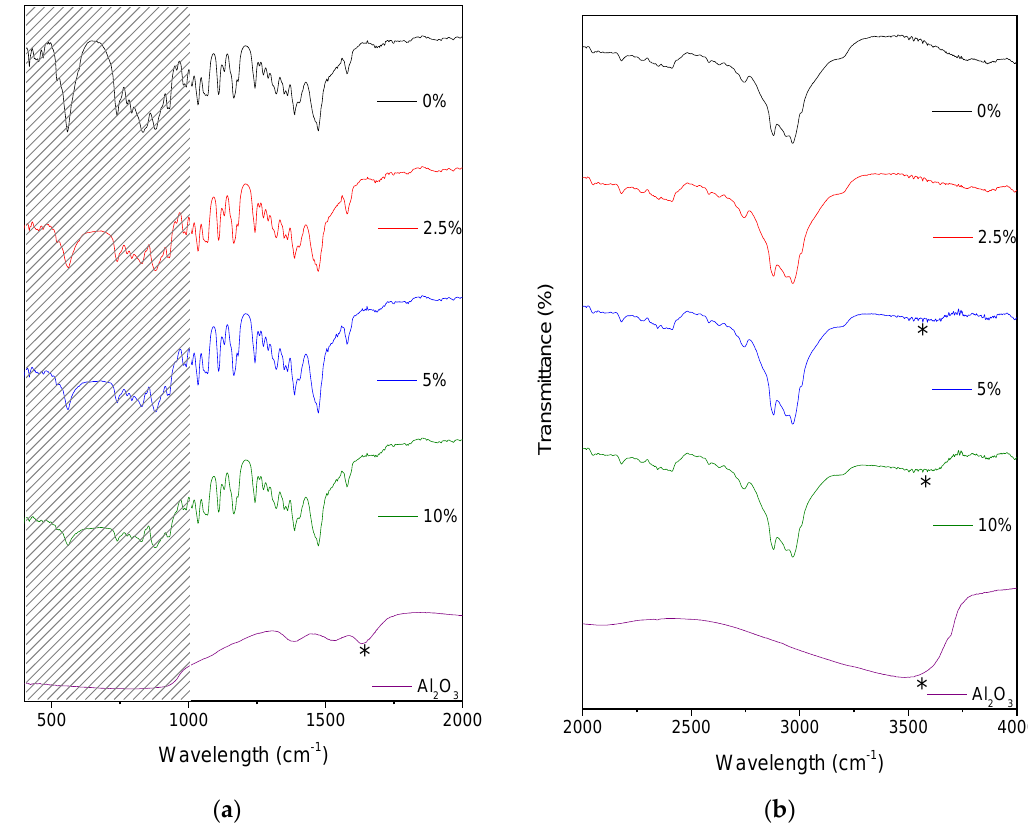
Figure 3. IR spectra obtained for TBA-PF 6 +Al 2 O 3 additive in range of ( a ) 400–2000 cm −1 and ( b ) 2000–4000 cm −1 , and the Al 2 O 3 additive.